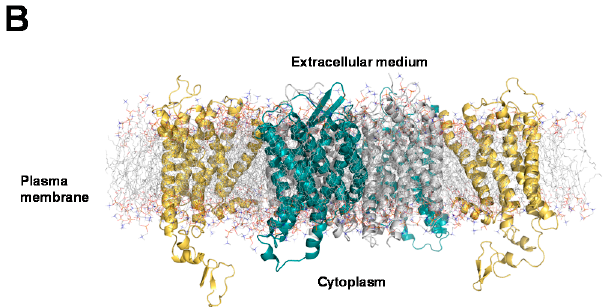
Figure 6. Structural modeling ( A ) and molecular dynamics simulations ( B ) of a hetero-hexameric receptor cluster consisting of the CXCR4, α 1A -AR and ACKR3. Transmembrane (TM) helices of CXCR4 (gray), α 1A -AR (yellow), and ACKR3 (green) are colored differently. TM helices of CXCR4 that participate in heteromerization interfaces with α 1A -AR and ACKR3 are colored in purple.